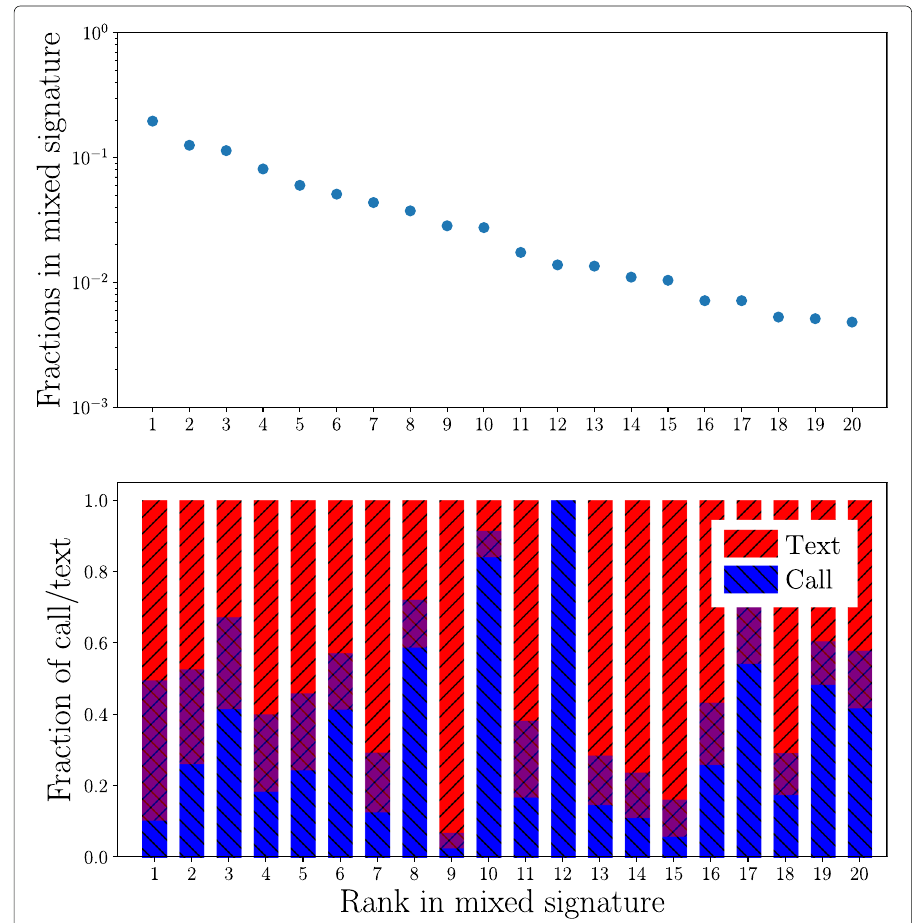
Fig. 5 The Composition of an Example Mixed Signature. Top panel: an example mixed signature for one of the egos in DS2. Bottom panel: fractions of calls and texts for the same ego, for each rank. The red and blue areas of the bars represent the fractions of texts and calls, respectively, of the link weight between the ego and the alter. The purple areas represent the fraction of time slots with both calls and texts